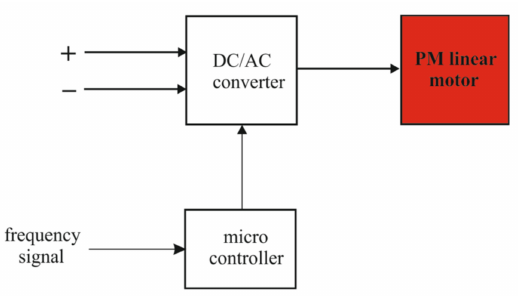
Figure 5. Block diagram of the motor drive operating in an open loop frequency control.